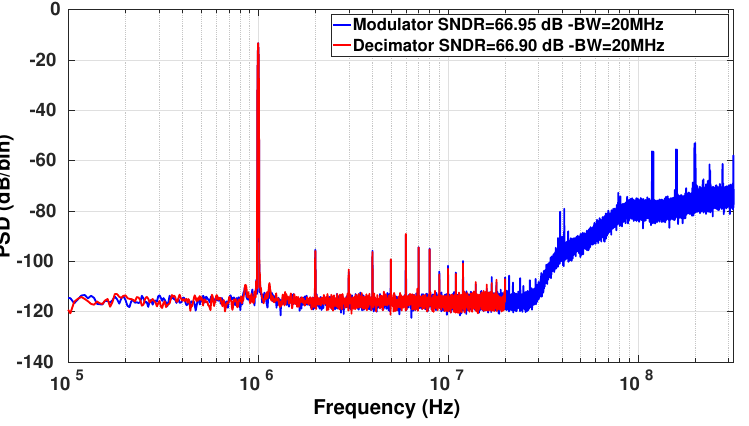
Figure 11. Spectrums of the modulator and decimator outputs for an OSR of 16.